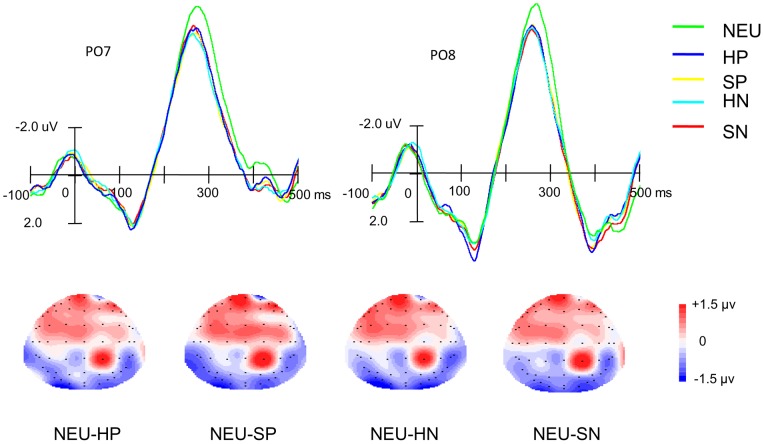
The top panel shows ERPs elicited by word processing under five emotional states at PO7 and PO8 electrodes.The bottom panel shows topographic maps for difference waves between neutral and each of the other four emotional states during the time window of 250–280 ms after stimulus onset. A clear recognition potential (RP) over the occipital scalp can be indentified under the neutral (NEU), highly positive (HP), slightly positive (SP), highly negative (HN) and slightly negative (SN) emotional states, which is highest in the case of the neutral emotional state.